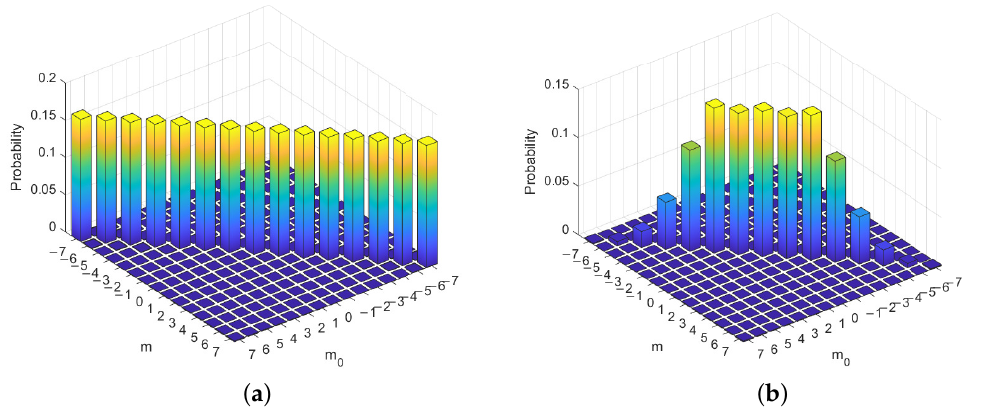
Figure 3. The received probability of OAM signal modes carried by POV versus different topological charge of initial OAM modes and topological charge of new OAM modes for r 0 = 0.03 m, ω = − 4.5, n I = 0.4487 × 10 − 9 . ( a ) z = 150 m, D = 0.02 m; ( b ) z = 150 m, D = 0.005 m.